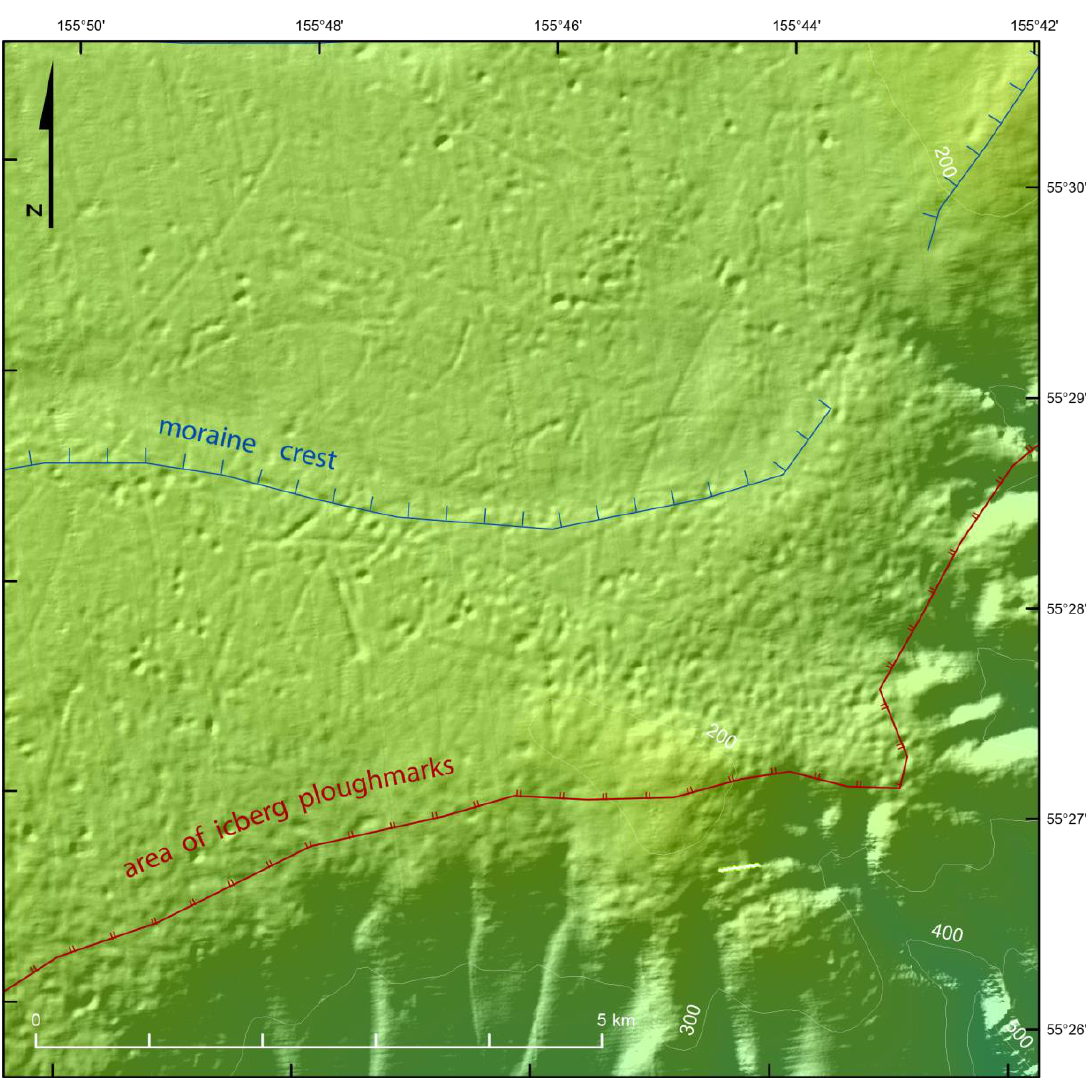
Figure 13. Iceberg ploughmarks on the moraine at the mouth of Shelikof Trough. Location of map